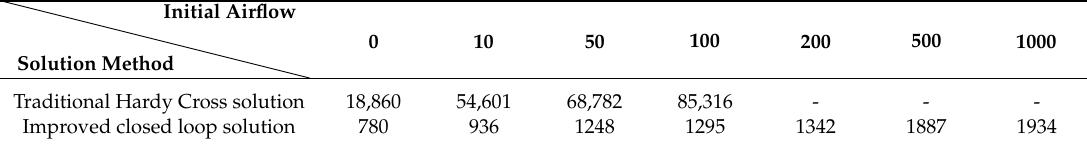
Table 7. Comparison of the iterative time (ms) for di ff erent specified initial airflows (m 3 / s) using the traditional Hardy Cross solution method with the improved closed loop solution